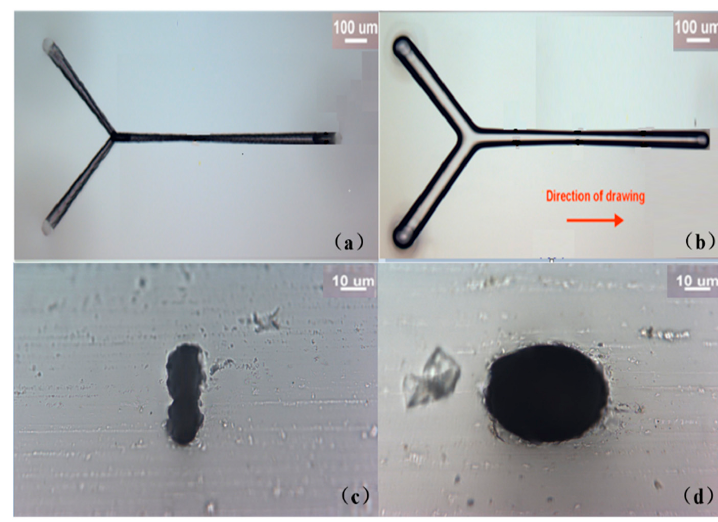
Figure 4. Optical micrographs of the Y-branched channels. Top view of the channels ( a ) before and ( b ) after drawing; and ( c , d ) cross section views of the middle regions of the channels in (a,b), respectively.